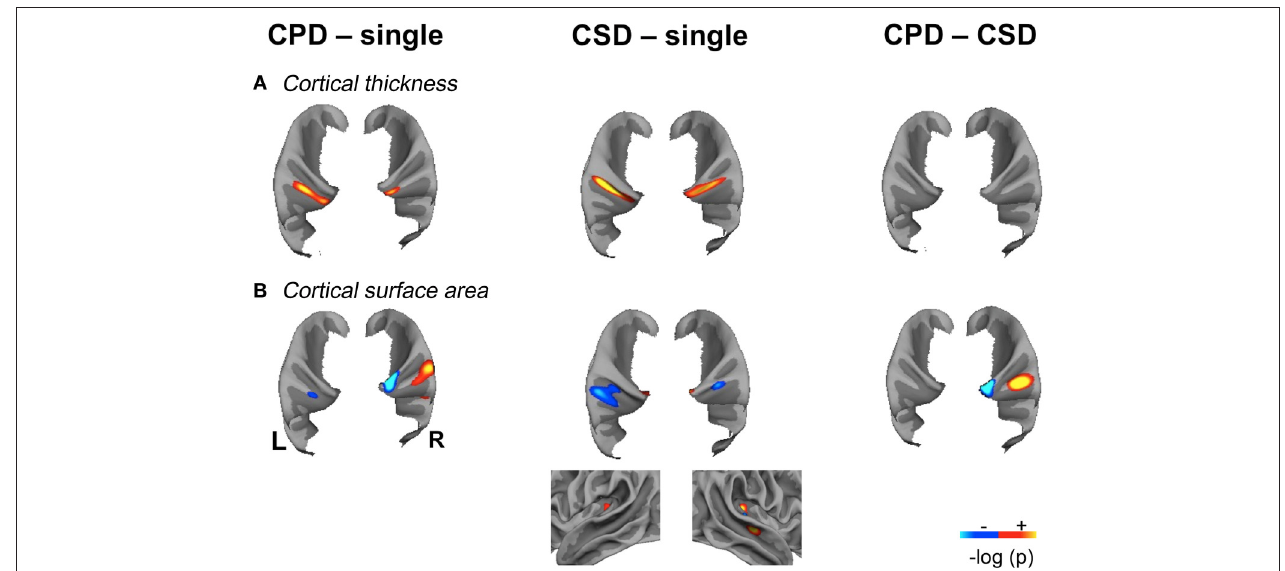
FIGURE 3 | Significant variations of Cortical Thickness (CT) and Cortical Surface Area (CSA) in the “CPD–single HG”, “CSD–single HG” and “CPD–CSD” contrasts in the left and right hemispheres showing the spatial overlap of CT and CSA variations. (A). Significant variations in cortical thickness. (B) . Significant variations in cortical surface area, the lateral view of the right temporal lobe is provided to illustrate the increase in CSA located in the mid-part of the STS in the “CSD–single HG” comparison. Significant variations are superimposed on the mean patch of each corresponding group (“CPD–single” and “CPD–CSD” contrasts: mean patch of 48 left CPD, mean patch of 96 right CPD; “CSD–single HG” contrast: mean patch of 98 left CSD and 95 right CSD; CSA: cortical surface area; CT, cortical thickness; CPD, common posterior duplication; CSD, common stem duplication; HG, Heschl’s gyrus; p < 0.05 FDR corrected for multiple comparison; cluster extension threshold, 20mm 2 ; hot color indicates a positive variation; cold color, indicates a negative variation; light gray, gyri; dark gray,